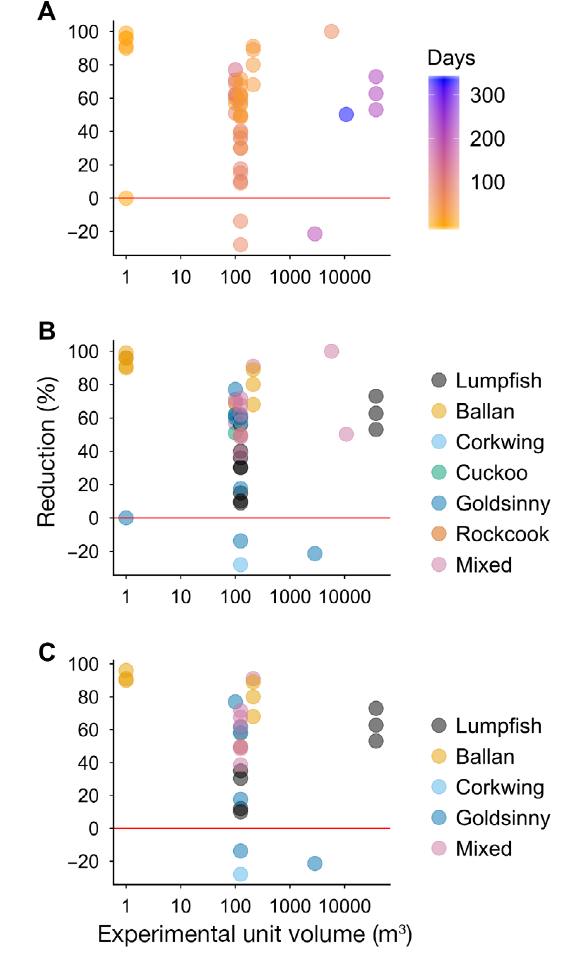
Fig. 2. Relationship between the volume of the experimental unit (tanks or cages) and the measured efficacy of cleaner fish, colour-coded by (A) the duration of the study, (B) the species of cleaner fish, or (C) the species of cleaner fish, ex- cluding studies that did not have 3 or more replicates per treatment. In C, where studies provided data for multiple treatment levels (e.g. stocking densities or cleaner fish body sizes) but did not meet the required replication within each treatment, we nonetheless included the study if taking the mean of treatment levels provided sufficient